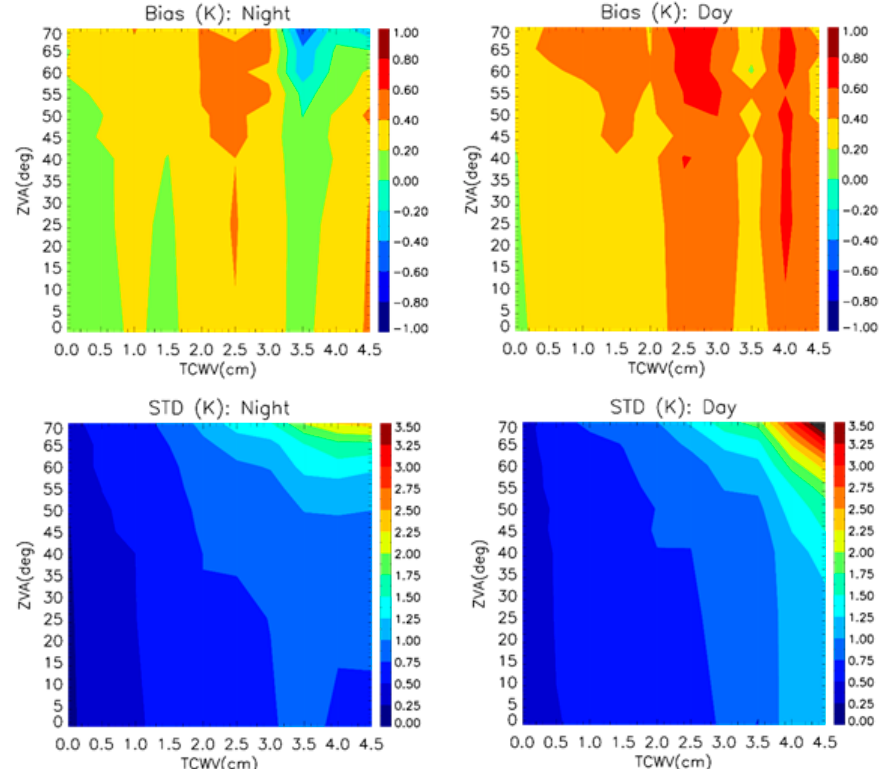
Figure5. StatisticalperformanceofthetheoreticalevaluationwithrespecttoTPWandViewzenithangle.